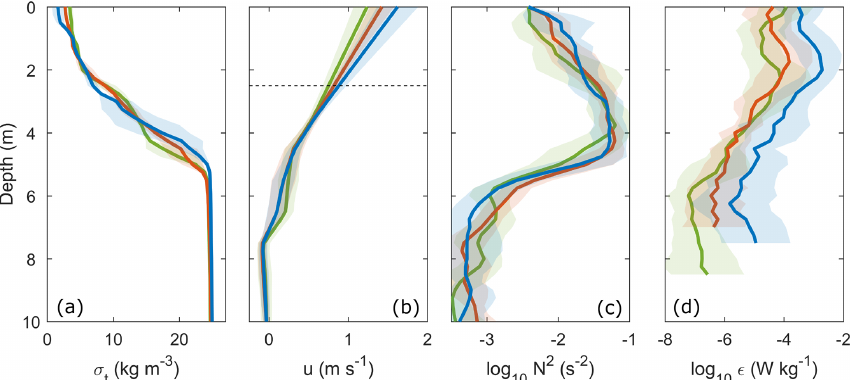
Figure 5. Vertical profiles of average ( a) σ t , (b) along-channel velocity ( u ), (c) stratification ( N 2 ) and (d) turbulence dissipation rate ( (cid:15) ), averaged over 0 < x ≤ 1km (blue), 1 ≤ x < 2km (orange) and 2 ≤ x < 3km (green). The horizontal dashed line in panel (b) shows the depth above which the velocity was interpolated. The shading around each profile represents 1 standard